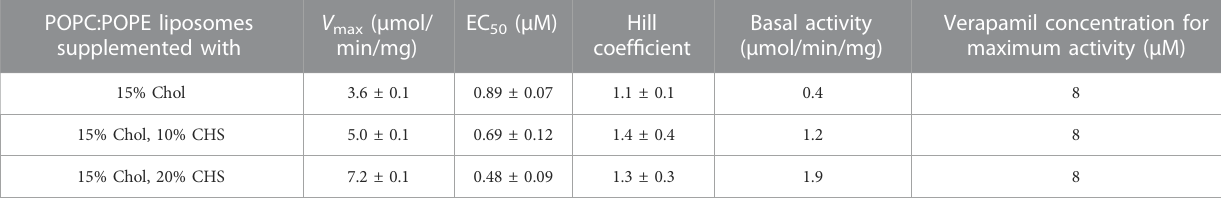
TABLE 5 Pgp was reconstituted into liposomes prepared from POPC/POPE with the indicated concentrations of CHS and the verapamil stimulation of ATPase activity was assayed ( n = 3). POPC:POPE liposomes supplemented with